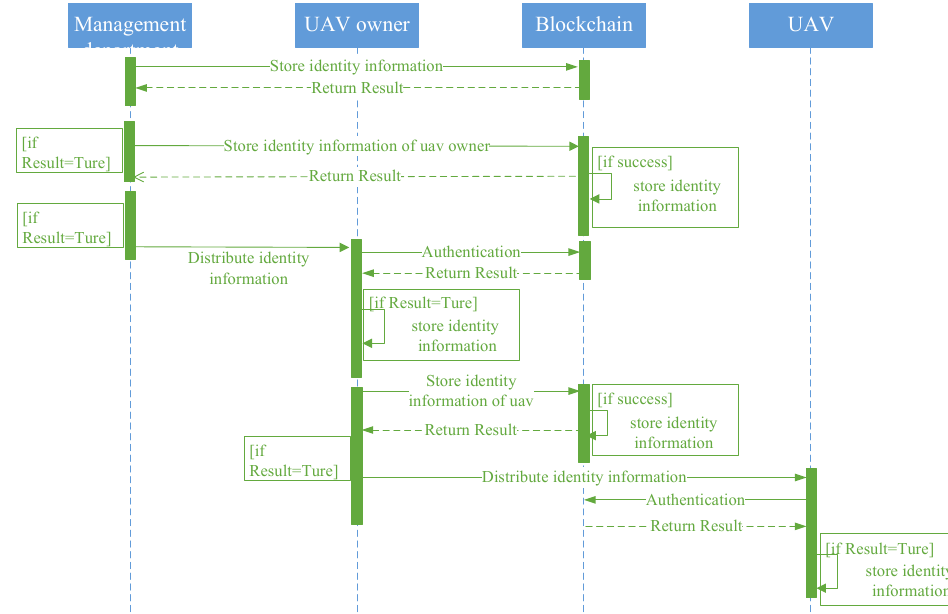
Figure 2. Blockchain-based identity information distribution